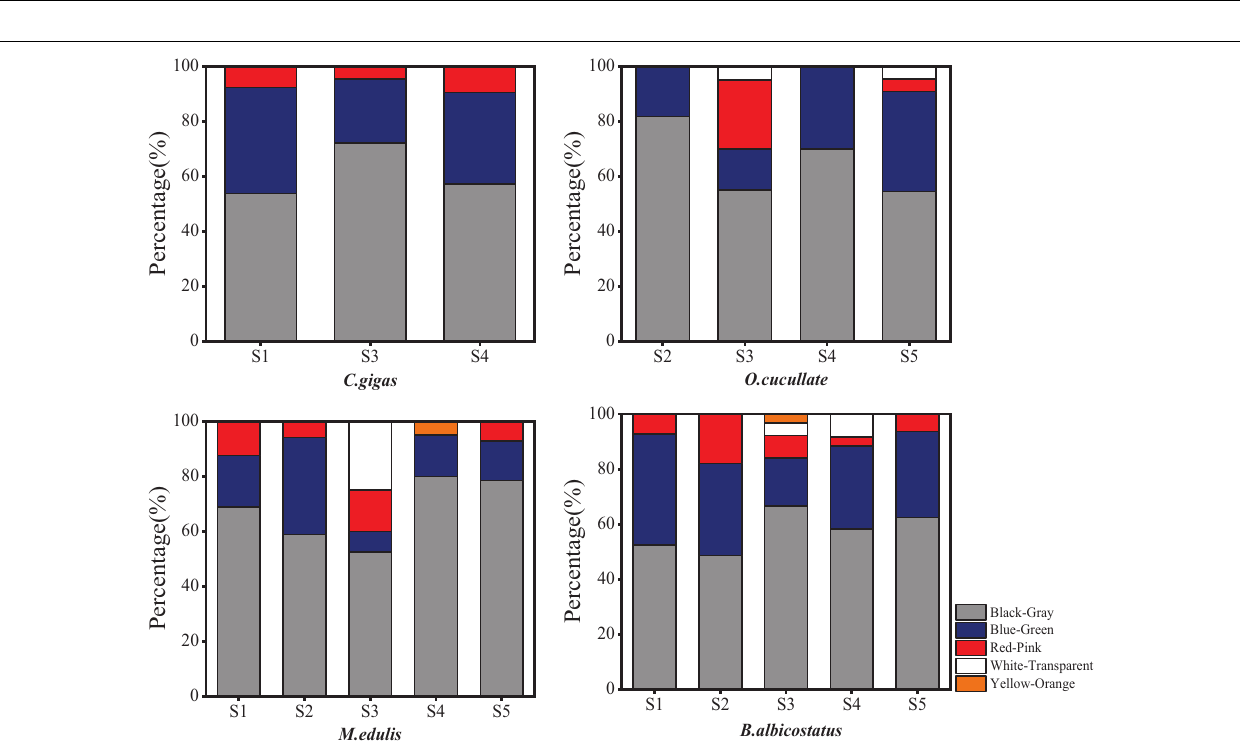
FIGURE 5 | Color distribution of MPs in four species of barnacles and wild bivalves from different sites in the Yellow Sea.